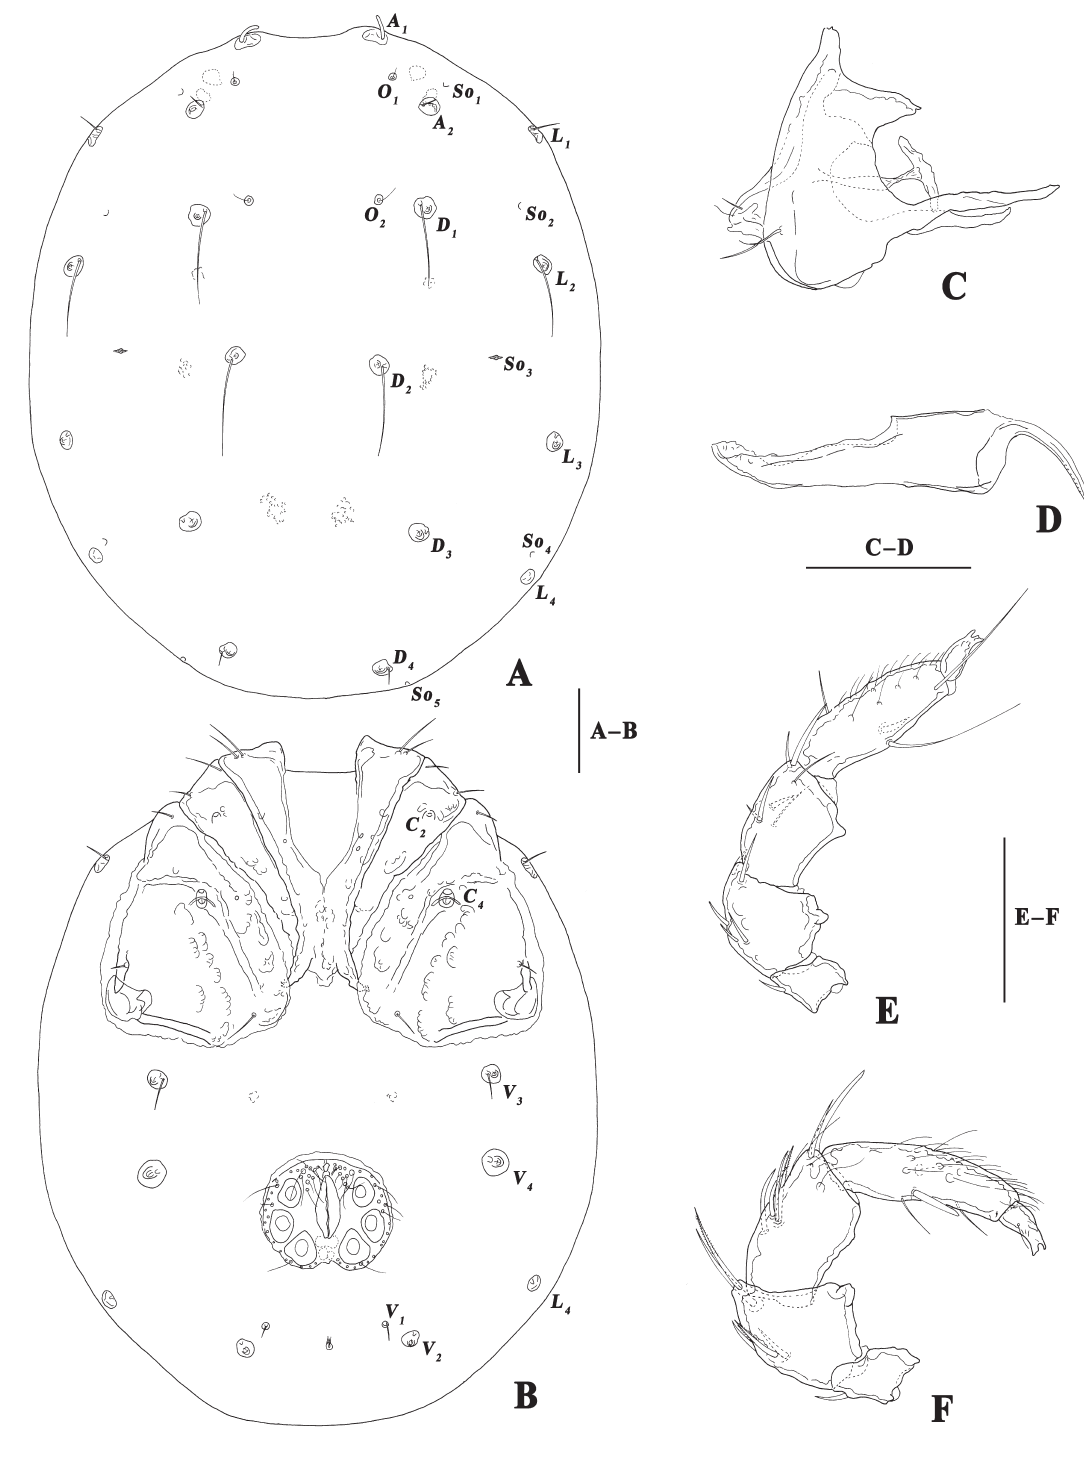
Fig. 11. Atractides ( Atractides ) xianmiensis Zhang, Li & Guo sp. nov. A–E . Holotype, ♂ (GUGC, Slide No. QH-HY-2020072910). F . Paratype, ♀ (GUGC, Slide No. QH-HY-2020072914). A . Idiosoma, dorsal view. B . Idiosoma, ventral view. C . Gnathosoma. D . Chelicera. E . Palp. F . Palp. Scale bars = 100